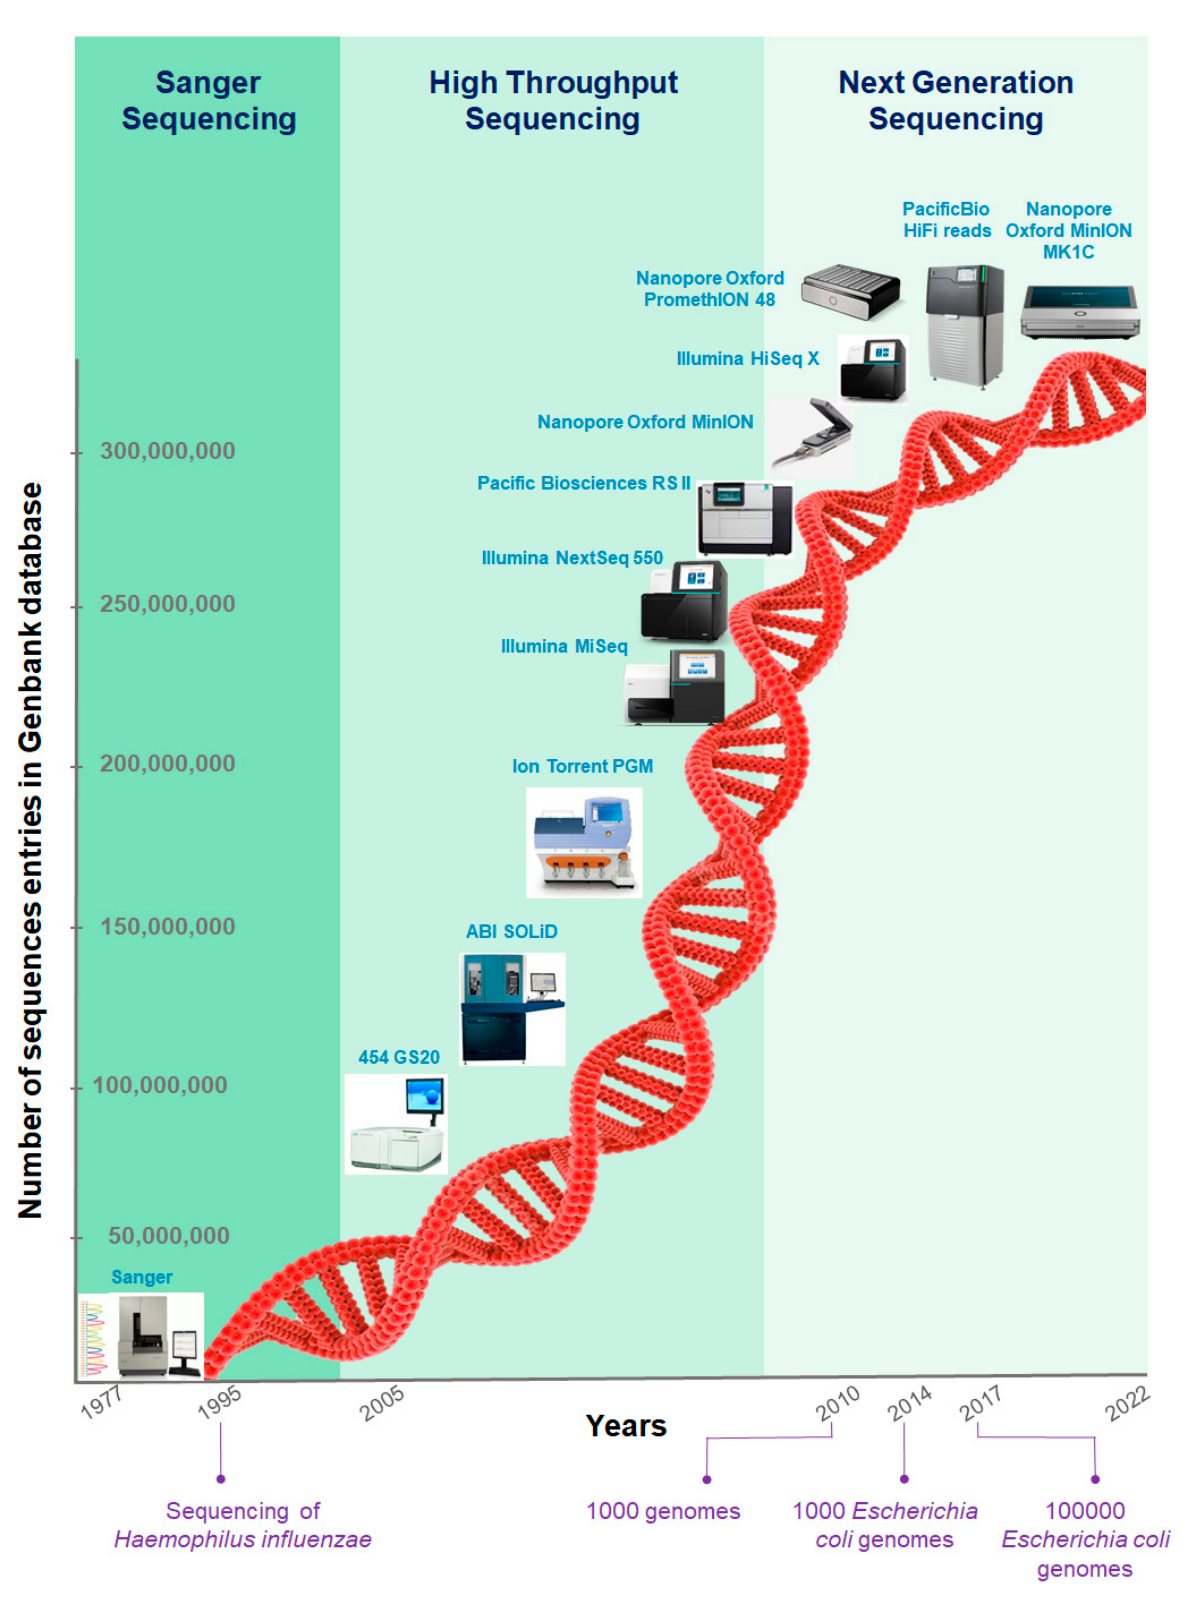
Figure 1. Overview of the evolution of bacterial genome sequencing.